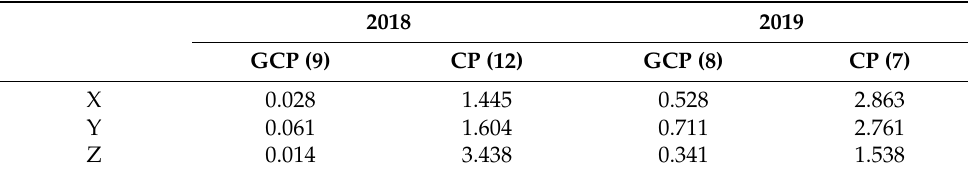
Table 1. Estimated RMSE (cm) at ground control points and check